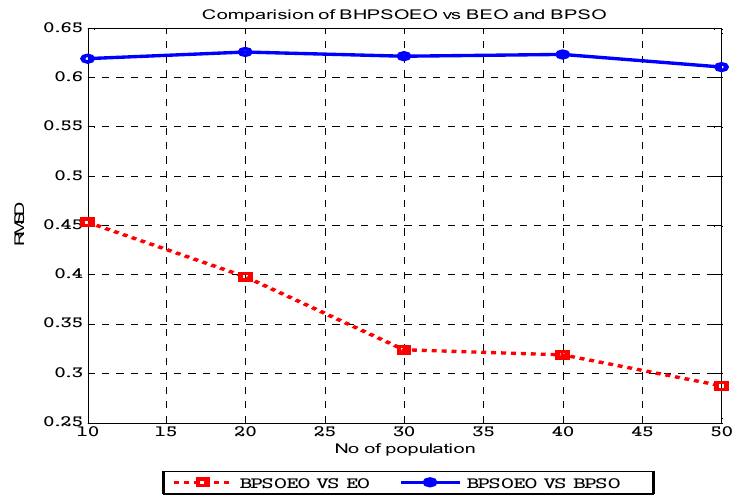
Figure 9. RMSD in average fitness for BPSOEO versus BEO and BPSO in cryptanalysis of the RC4 cipher when text length is 64 bits.